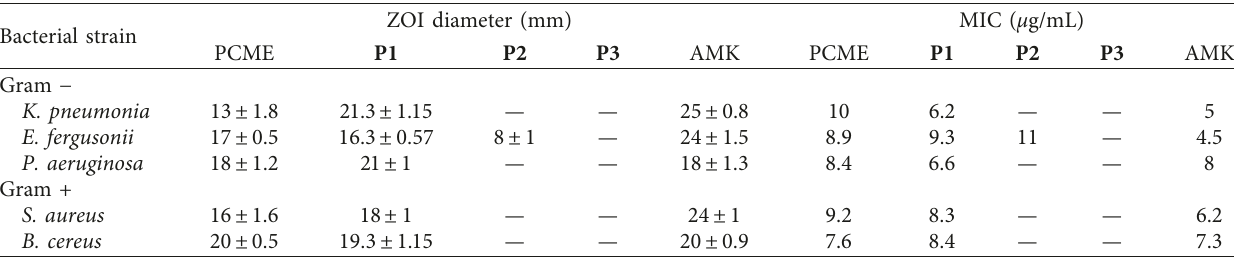
Table 4: Antibacterial activity of PCME and P1 , P2 , and P3 .